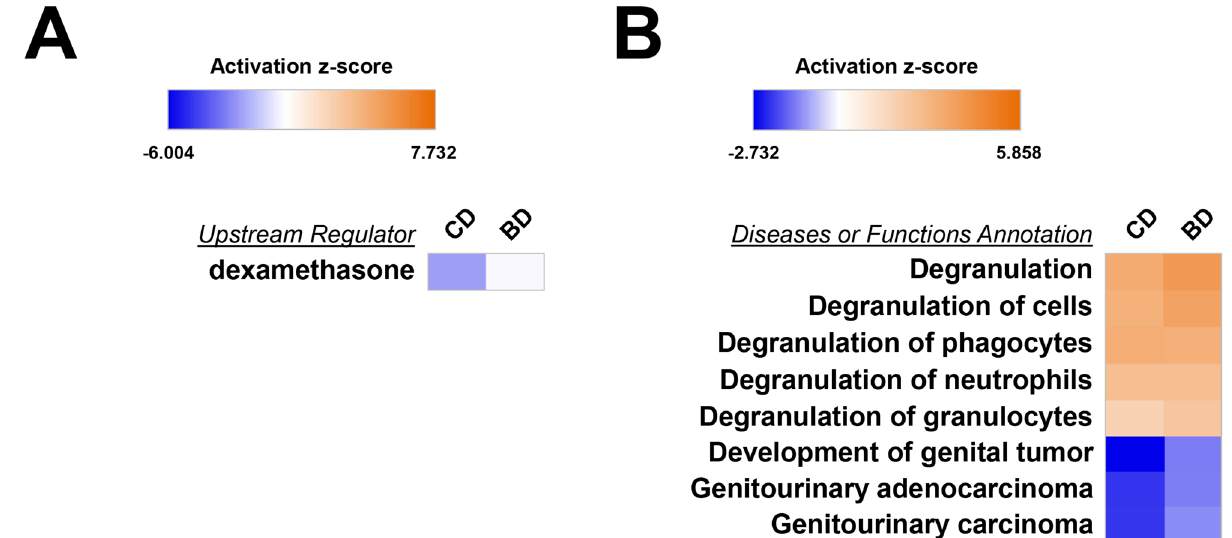
Figure 6. Ingenuity pathway analysis (IPA) of the MGAM-related upstream regulator ( A ) and disease or functional annotations ( B ) in colon mucosa proteomes of internal BD and CD. IPA core analyses were performed for a proteomic comparison between internal BD and CD using 3,614 UniProt accession numbers. Significant MGAM-related functional annotations are shown (z-score > 2, p < 0.05). Heat maps illustrating the predicted activation z-score. The color range indicates its predicted activation state: increasing (orange) or decreasing (blue).